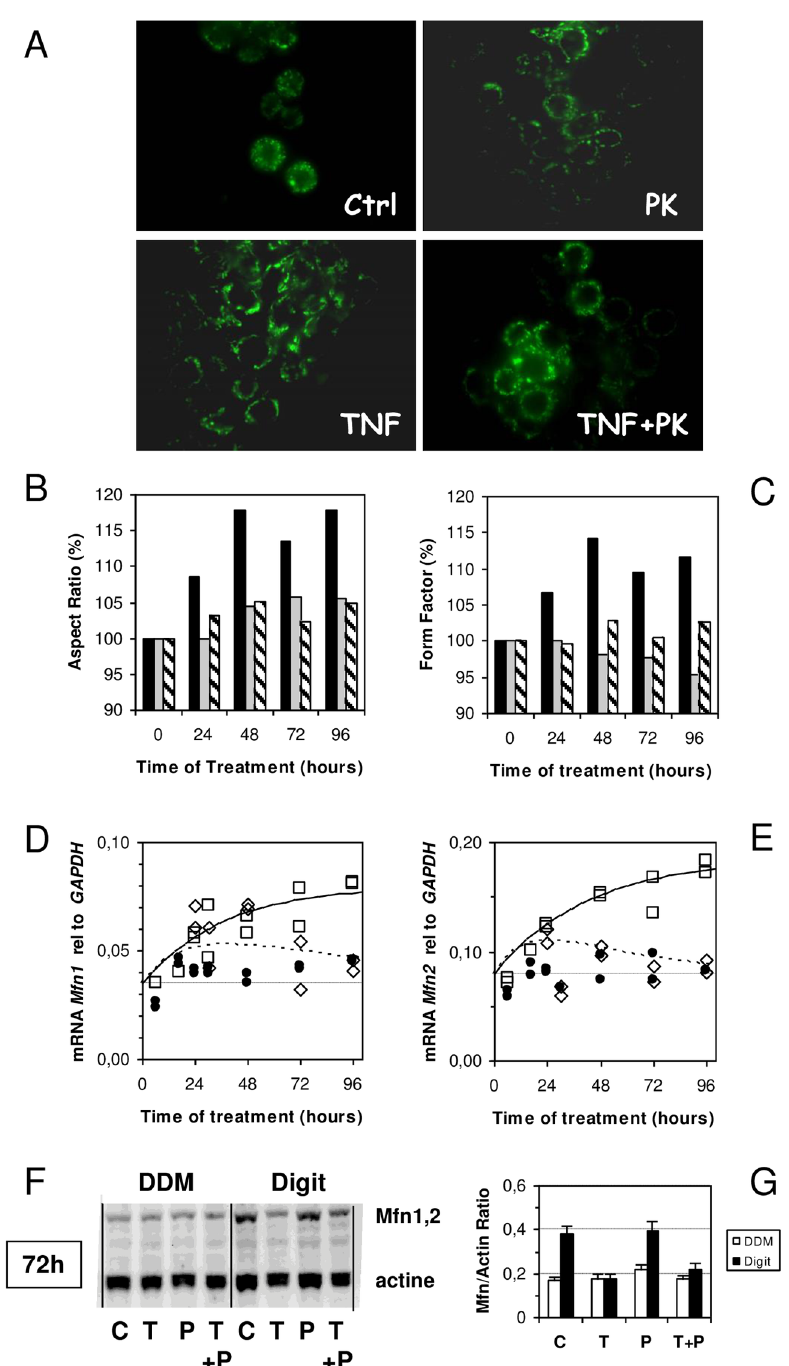
Fig 6. HT-29 cells ’ mitochondrial networks and fusion proteins upon TNF treatment. (A), Representative images of HT-29 cells expressing green fluorescent protein (GFP) targeted to mitochondria in control and treated cells. (B and C) Quantitative analysis of mitochondrial structure using morphological parameters (Aspect Ratio and Form Factor) following Koopman et al. treatment. [23] At least 500 – 600 mitochondria were analyzed per condition and normalized to control conditions. The time course of the Aspect Ratio (B) and Form Factor (C) changes in TNF-treated cells (black bars), 1 μ M of PK 11195-treated cells (grey bars), and cells treated simultaneously with 10 ng/mL of TNF and 1 μ M of PK 11195 (dashed bars). mRNA expression of mitofusins ( Mfn1 and Mfn2 in panels D and E, respectively) relative to GAPDH as a function of time of treatment with 10 ng/mL of TNF (open square), the simultaneous presence of TNF and